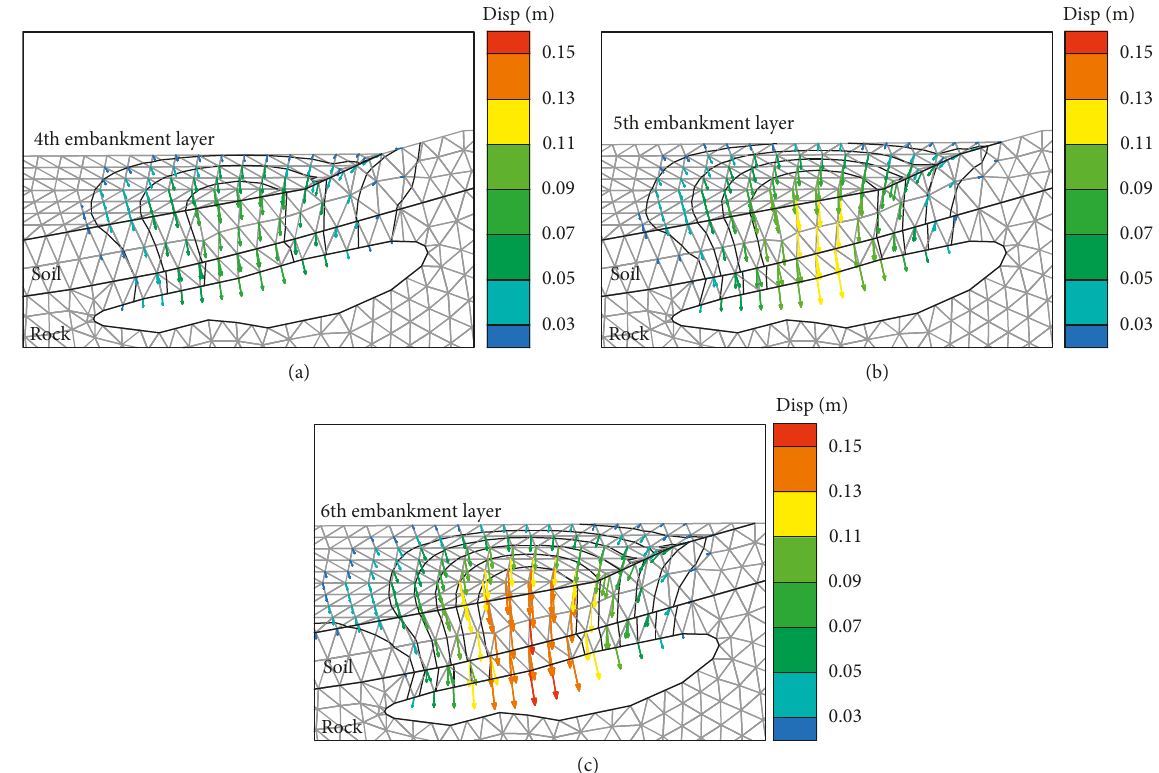
Figure 21: The evolution of the displacement vector field during the embankment construction process.